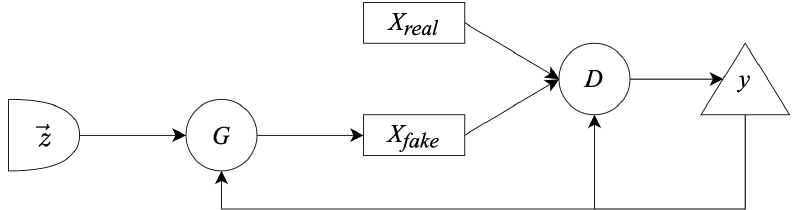
Figure 8. A GAN diagram. G is given random noise (cid:126) z , usually from a multivariate normal distribution, to generate a set of data points, X fake . D is provided with both the original data, X real and the generated data. D outputs a label y , denoting if a given observation is fake (was produced by G ) or real (came from the original